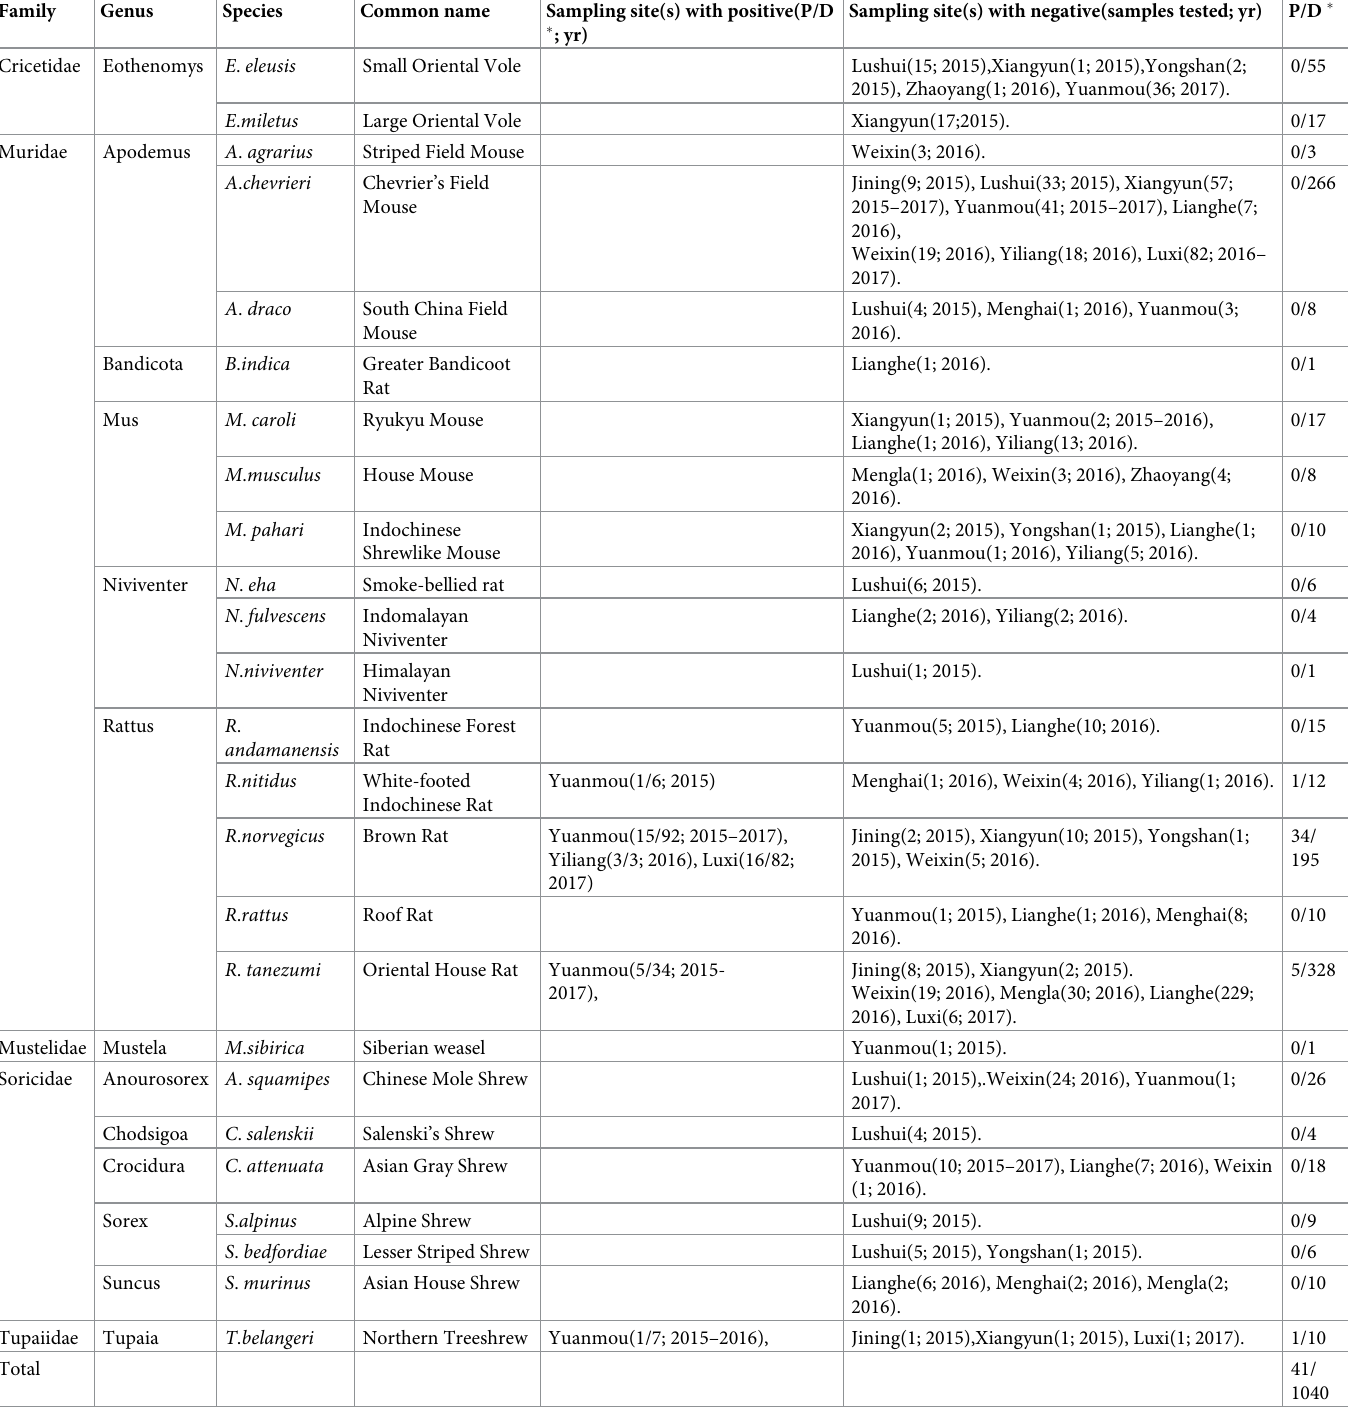
Table 1. PCR detection results for Arenavirus in small mammals collected in Yunnan Province during 2015 to